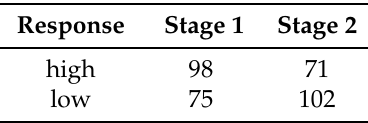
Table 3. Distribution of high-low categories through both